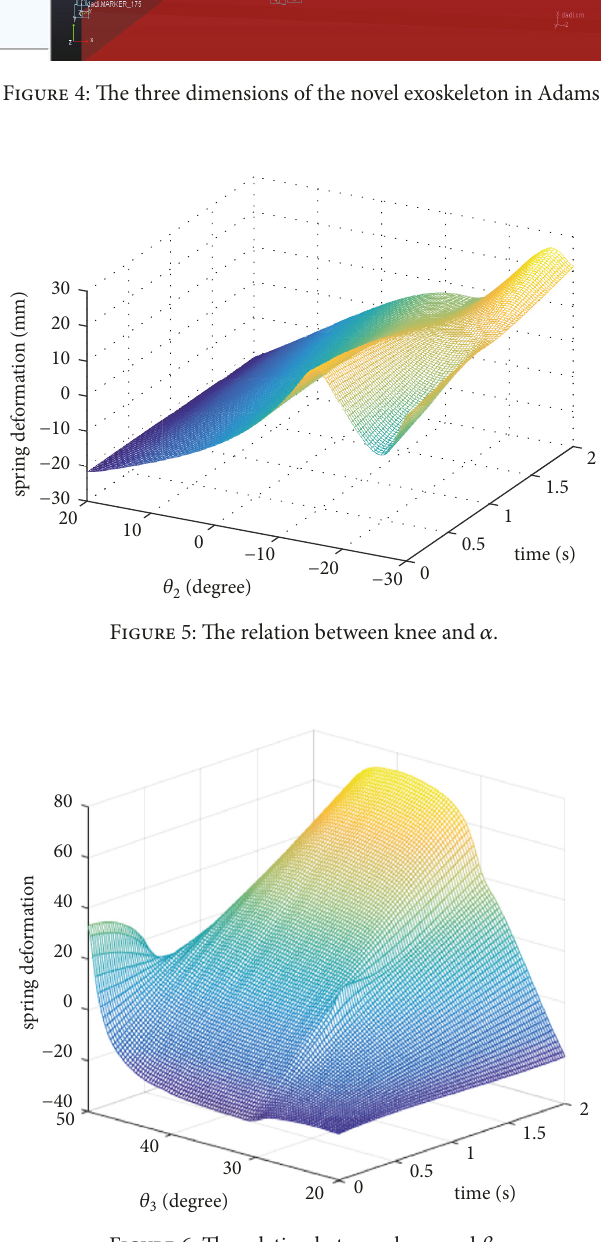
Figure 6: The relation between knee and 𝛽